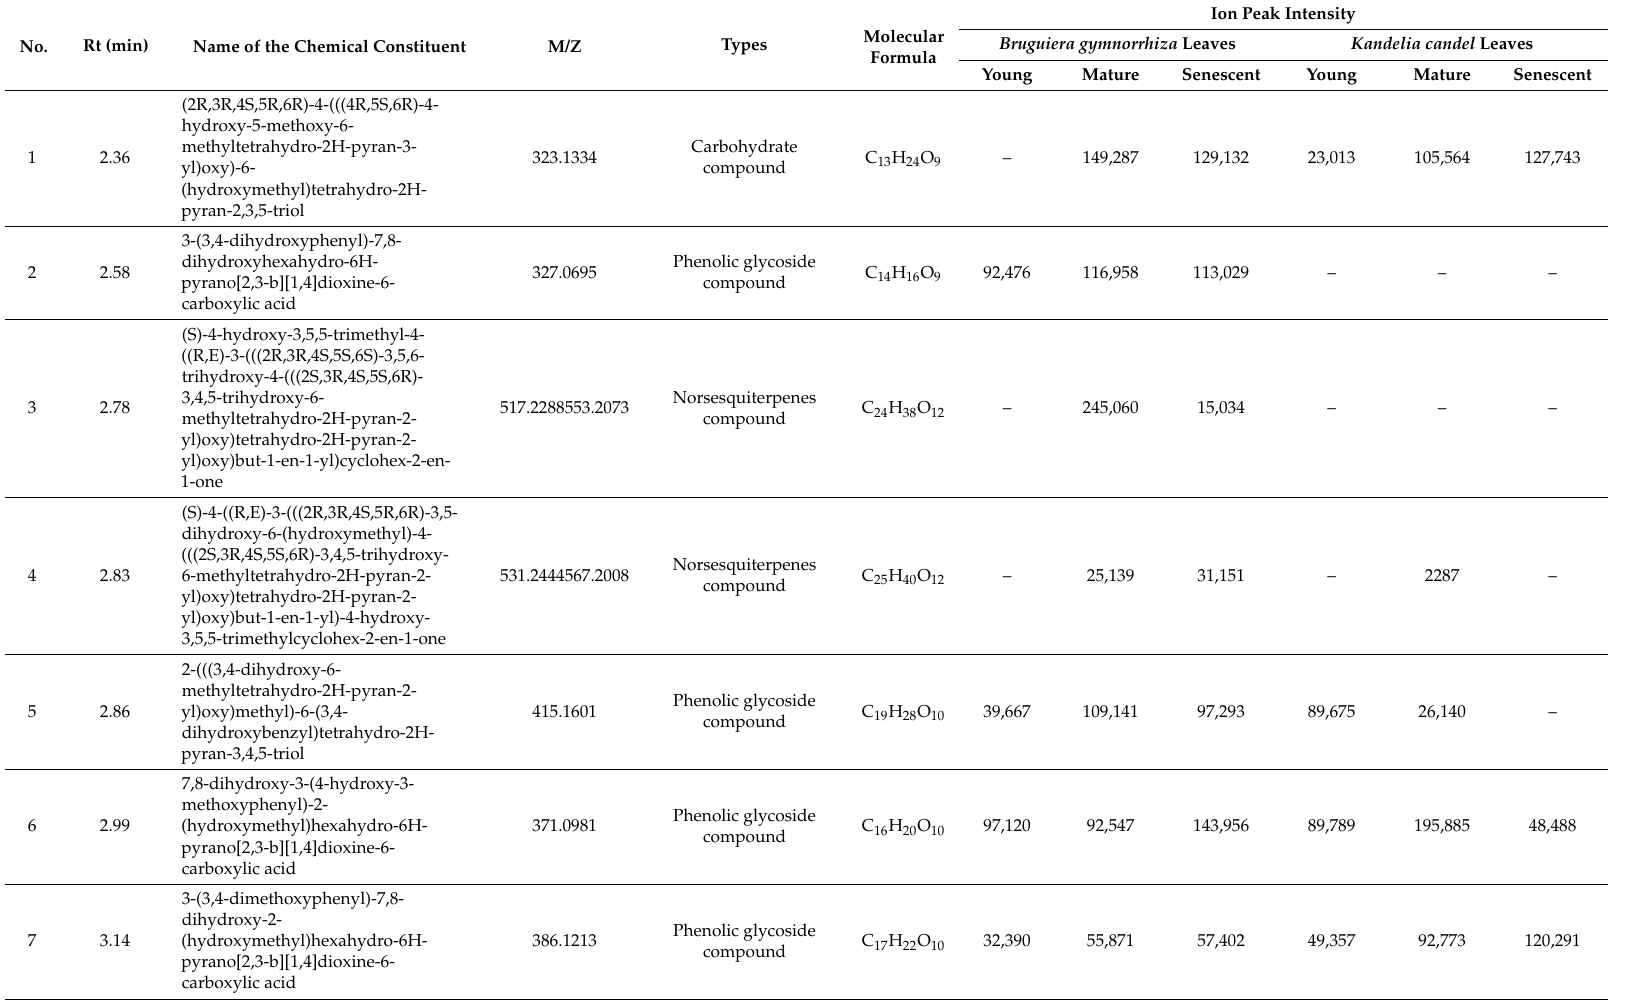
Table 1. Identification of chemical constituents from B. gymnorrhiza and K. candel leaves aqueous extracts.